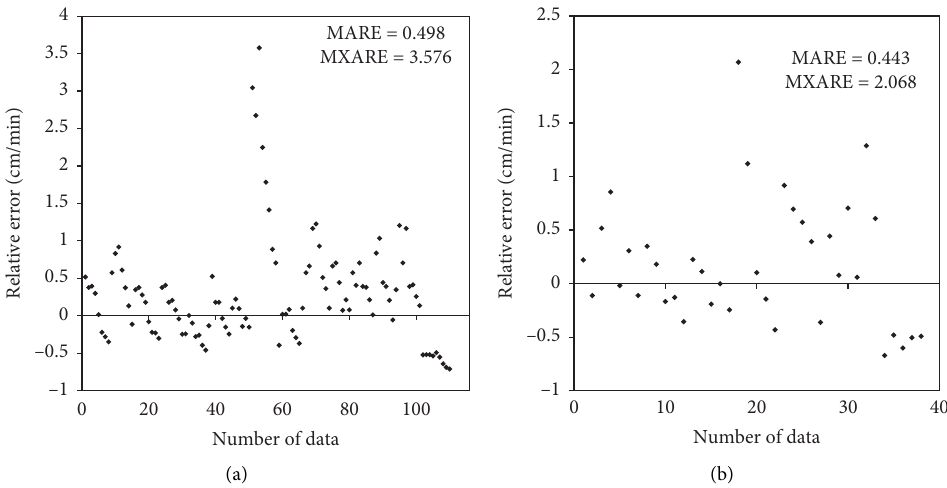
Figure 3: Relative error plots for Horton’s model for the training and testing data.